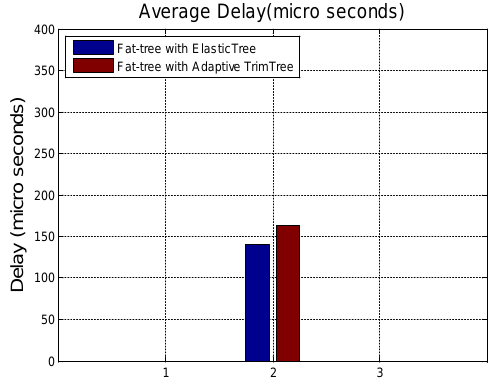
Figure 9. Average delay Adaptive TrimTree vs. ElasticTree.